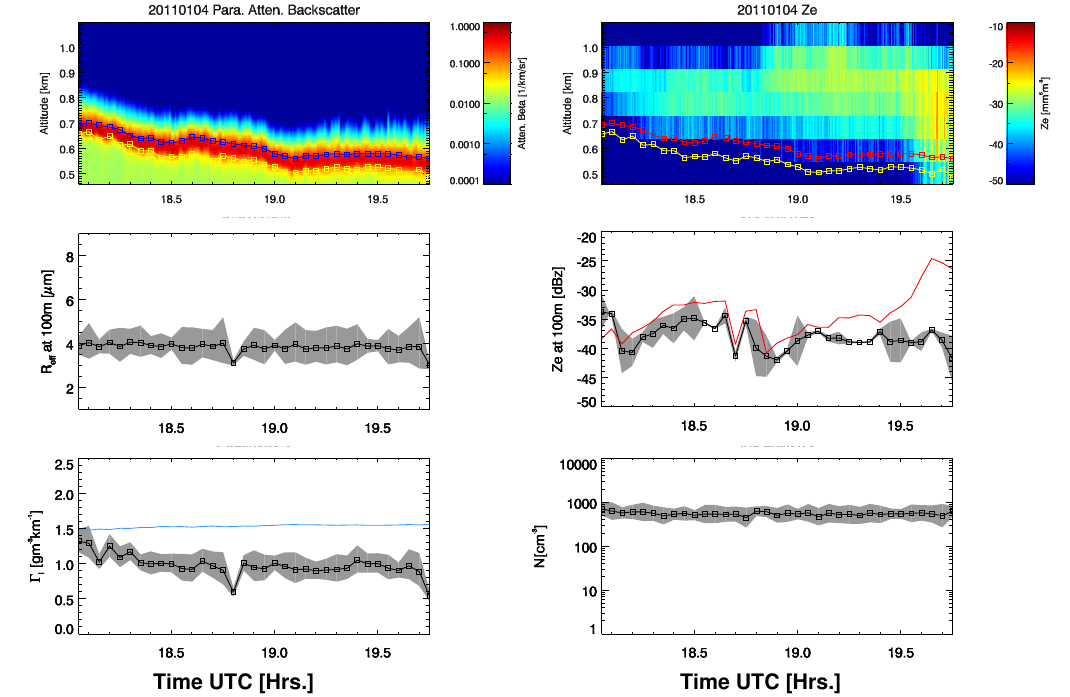
Figure 16. As Fig. 15 except for data corresponding to 4 January 2011.